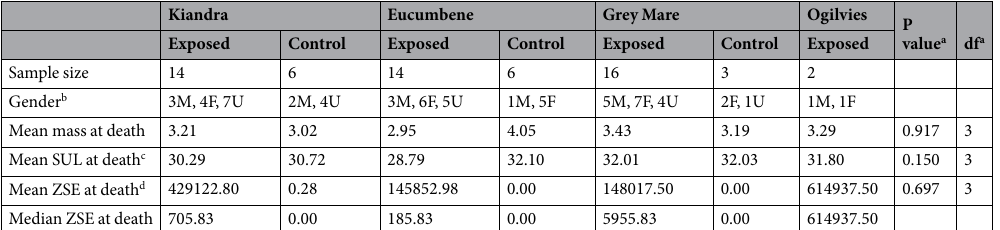
Table 2. Demographic characteristics of study subjects (including sample size, treatment group, gender ratios, mean mass at death, mean snout-urostyle length at death and mean and median infection intensity at death). a Statistics comparing means between populations (pooling exposed and control frog values) using one-way ANOVA, P value and df degrees of freedom; b Genders represented by M for males, F for females and U for unknown gender; c SUL is snout-urostyle length measured with Vernier callipers; d ZSE is zoospore equivalents as measured by